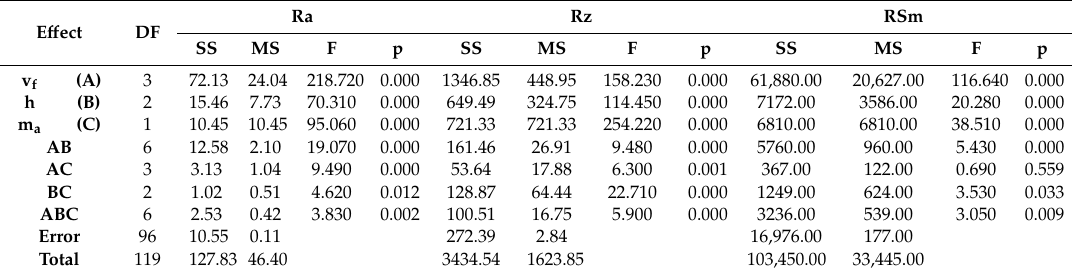
Table 6. ANOVA for di ff erent roughness parameters—Ra, Rz, and RSm (AlSi21CuNi alloy). E ff ect